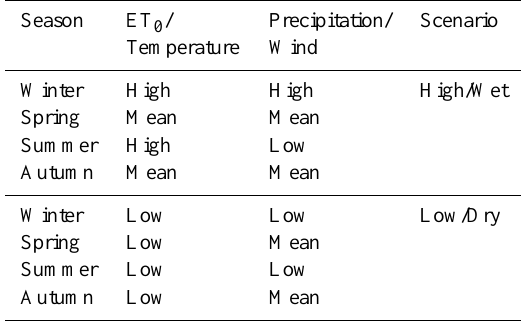
Table 2. CCI-HYDR impact scenarios and related changes in pre- cipitation, temperature, ET 0 and wind (Baguis et al.,